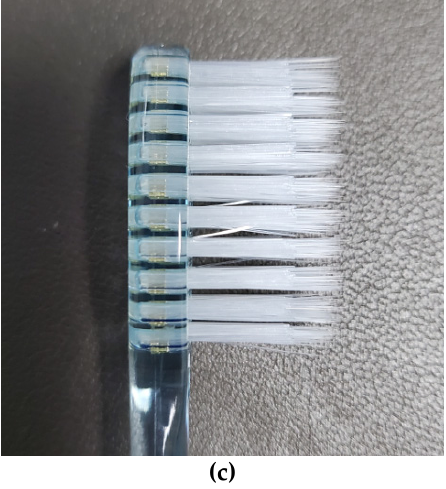
Figure 2. ( a ) Proxywave ® test brush, ( b ) Side view of the Proxywave ® toothbrush, ( c ) Side view of the control toothbrush (Baekje Industry) brush is identical to the tested toothbrush.